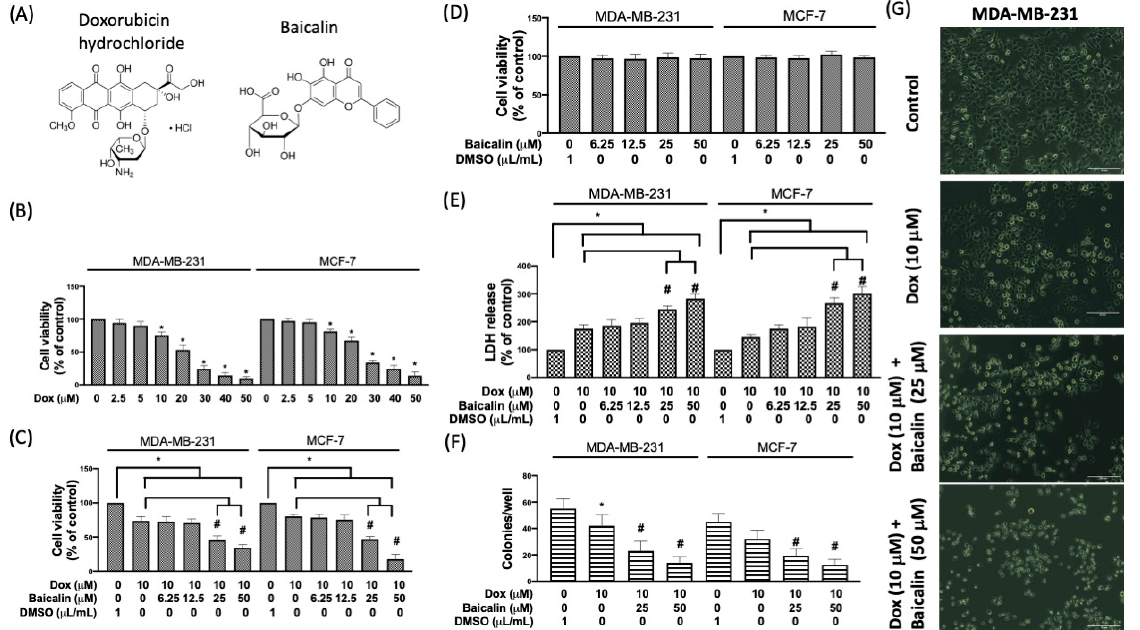
Figure 1. Baicalin promotes doxorubicin (Dox)-reduced cell viability and cell survival under Dox treatment in MDA-MB-231 and MCF-7 breast cancer cells. ( A ) Structures of dox and baicalin. ( B ) MDA-MB-231 breast cancer cells were incubated with Dox (2.5–50 μ M) for 24 h; viability was detected using the MTT assay. ( C ) Cotreatment of 10 μ M Dox with various concentrations of baicalin. ( D ) A single infusion of baicalin did not reduce the cell viability. ( E ) Cell cytotoxicity was determined according to the level of released lactate dehydrogenase (LDH) from cells. ( F ) Quantification of single-cell clone proliferation after Dox treatment. ( G ) Cells express blebbing membranes, where a shrunken or rounded and condensed morphology was more common following treatment with 10 μ M Dox and was further induced in baicalin-coincubated cells. Data are expressed as the mean ± SEM of three independent analyses; * p < 0.05 versus untreated control, # p < 0.05 versus Dox treatment.